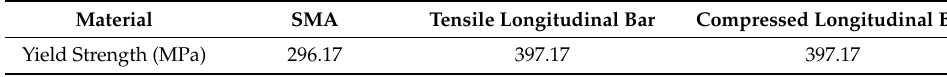
Table 4. Yield strength of longitudinal reinforcement.